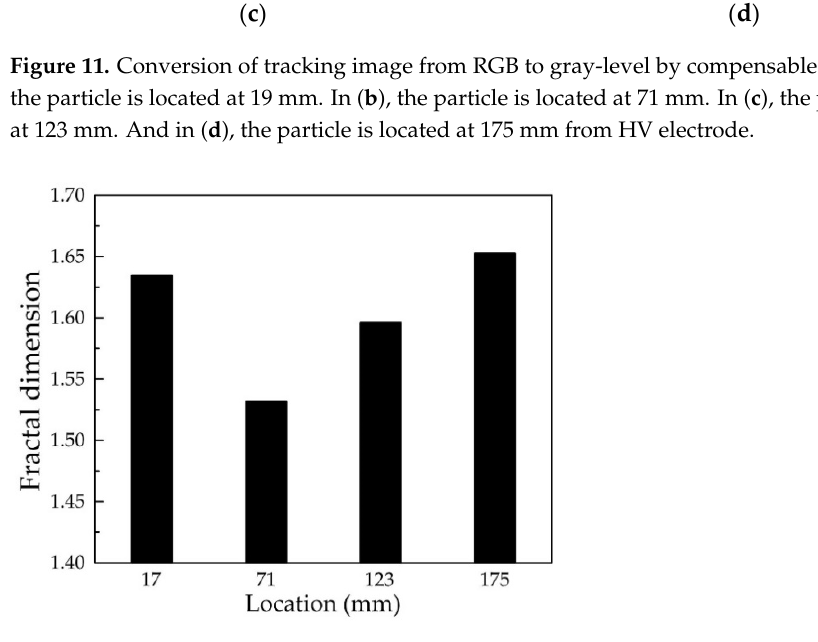
Figure 12. FD of tracking calculated according to BCM with particle at various locations. With varying the location of particle, FD of tracking shows corresponding